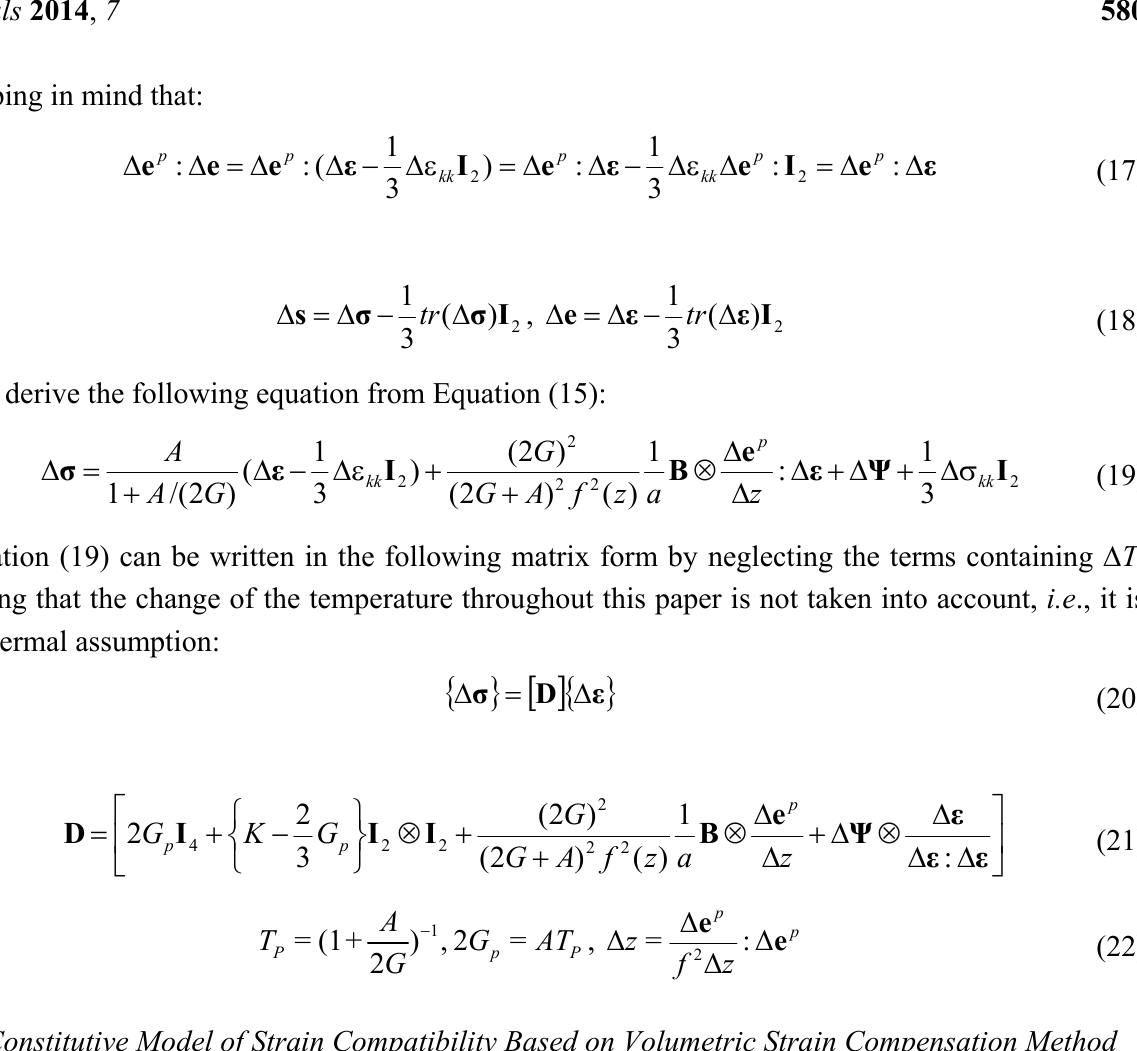
is the thickness of martensite lamella. m x